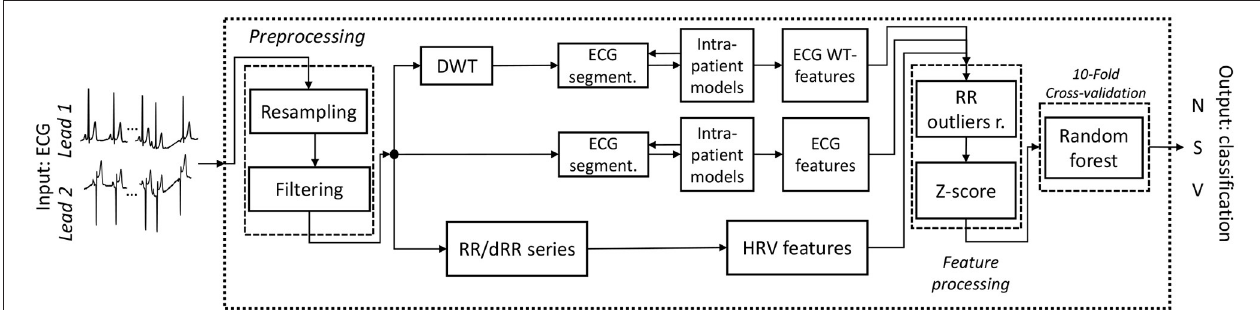
TABLE 1 | PhysioNet and simplified beat annotations per database. Simp. Annotations N S V J Q Beat Annotations B stands for bundle branche block beat, N for normal beat, A for atrial premature beat, a for aberrated atrial premature beat, e for atrial escape beat, S for supraventricular premature or ectopic beat (atrial or nodal), V for premature ventricular contraction, F fusion of ventricular and normal beat, E for ventricular escape beat, J for nodal (junctional) premature beat, j for nodal (junctional) escape beat and Q for unclassifiable beat.